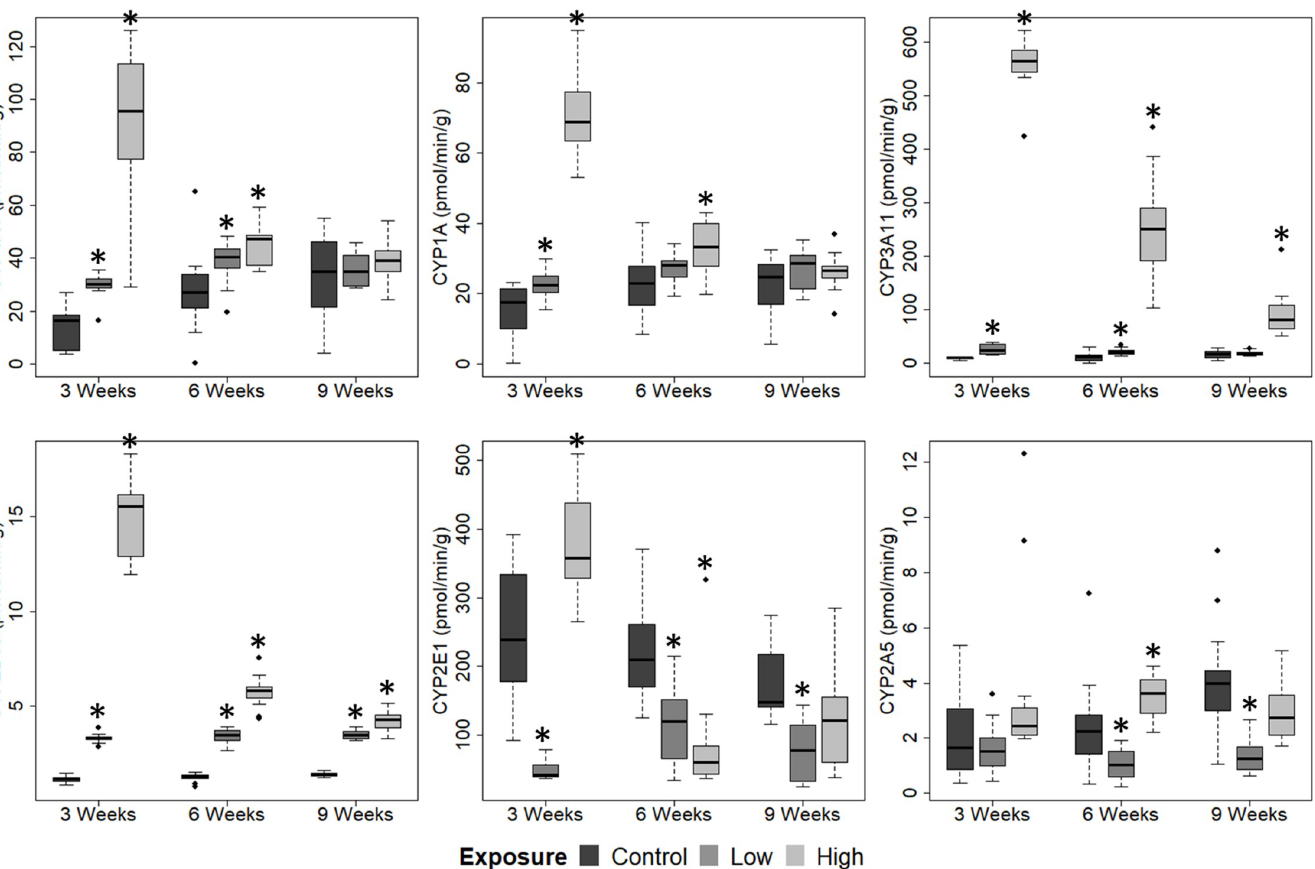
Fig 4. Hepatic enzymatic activity. The activities of cytochrome P450 (CYP) 1A1, 1A, 3A11, 2B10, 2E1 and 2A5 in female offspring maternally exposed to a mixture of POPs at Control, Low or High doses (0x, 5000x or 100 000x human estimated daily intake, respectively). Samples were taken at 3 (n = 12), 6 (n = 14) and 9 (n = 14) weeks of age. Activities were measured as a rate of 7-ethoxyresorufin (CYP1A1), 7-methoxyresorufin (CYP1A), benzyloxyresorufin (CYP3A11), 7-pentoxyresorufin (CYP2B10) dealkylation, and p-nitrophenol (CYP2E1) and coumarin-7 (CYP2A5) hydroxylation. Boxplots consist of 25 th , 50 th (median) and 75 th percentiles, whiskers (extending to 1.5 interquartile range) and outliers (•). Significant difference from Control (p � 0.05) is marked by � .